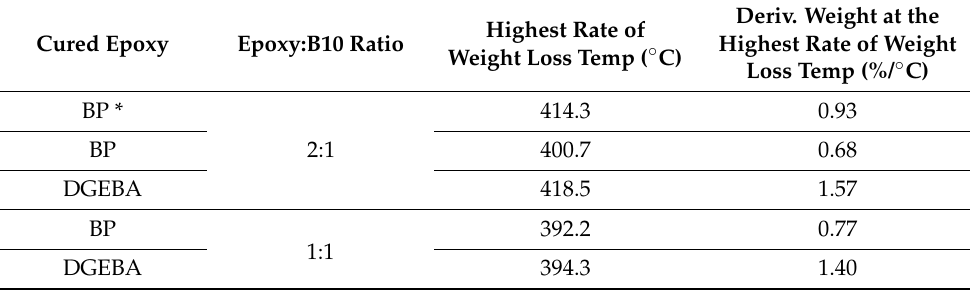
Table 2. Highest rate of weight loss temperature and derivative weight of cyanate ester (B10)-cured epoxy